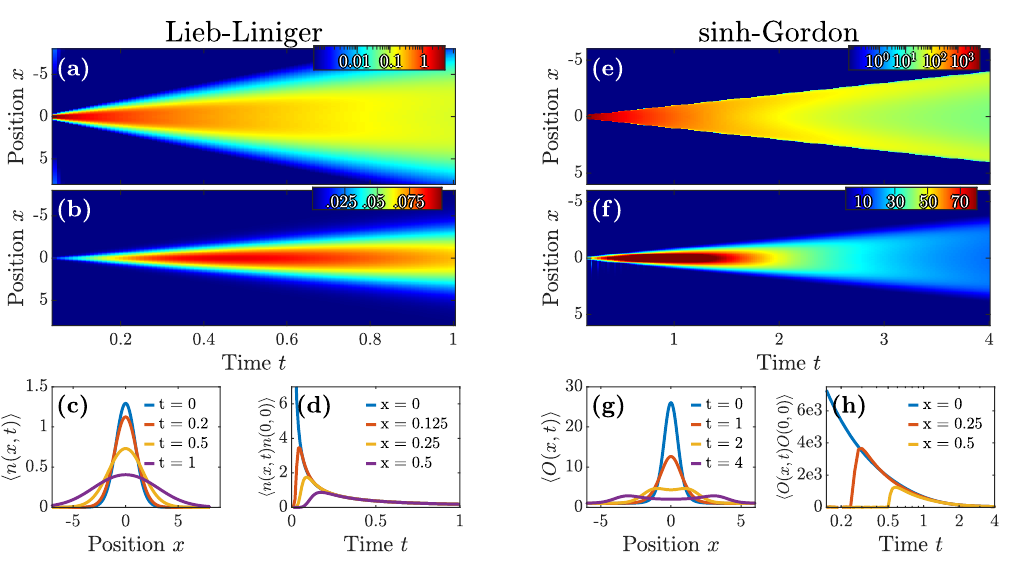
(cid:10) (cid:11) Eul O ( x , t ) O (cid:48) ( 0,0 ) , of bump releases in the Lieb- [ ϑ ] 0 . (a,e) Direct , 2